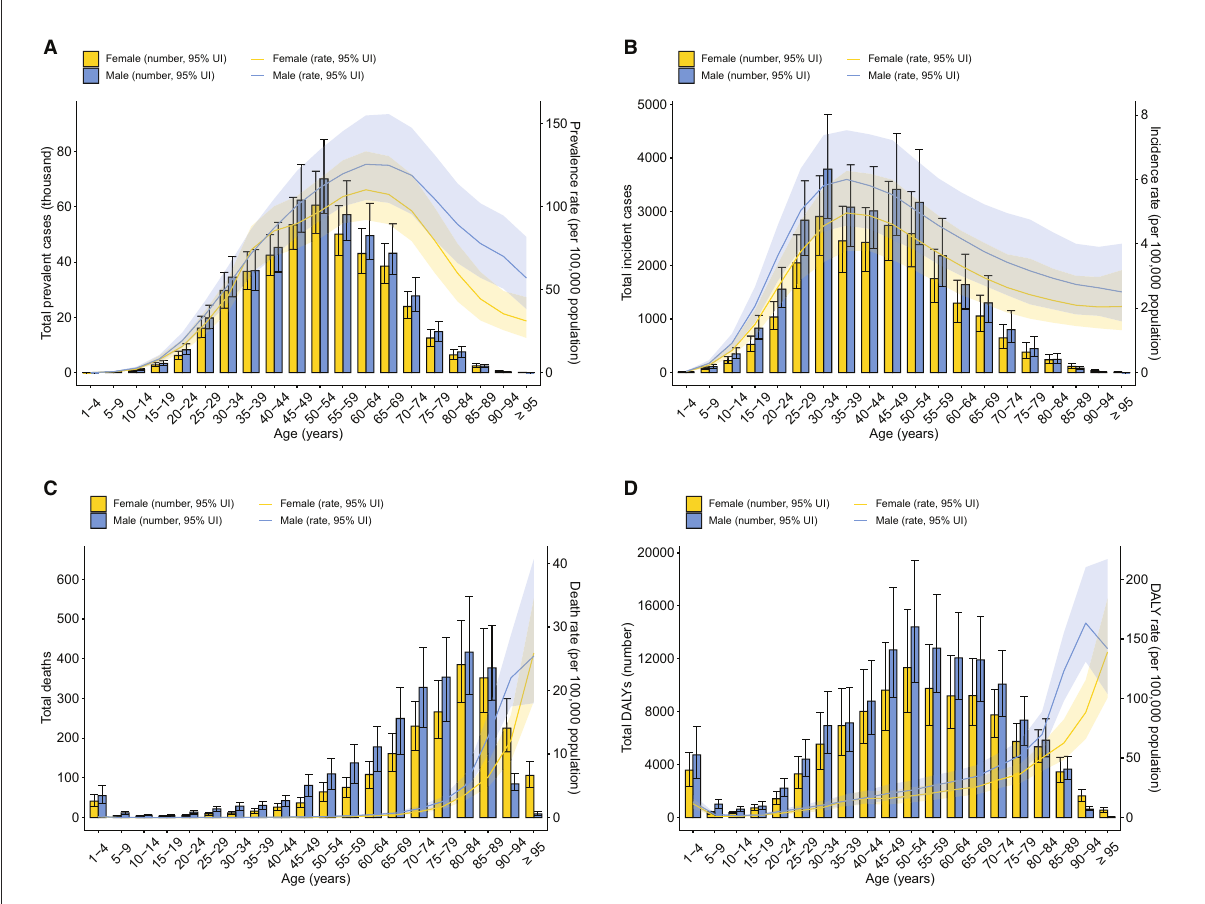
FIGURE2 Age patterns by sex in 2019 of number and age-specific rates of prevalence (A) , incidence (B) , deaths (C) , and DALYs (D) due to IBD in China. Error bars indicate the 95% uncertainty interval (UI) for the number of each measure. Shading indicates the 95% UI for the age-standardized rates. DALYs, disability-adjusted life-years; IBD, inflammatory bowel